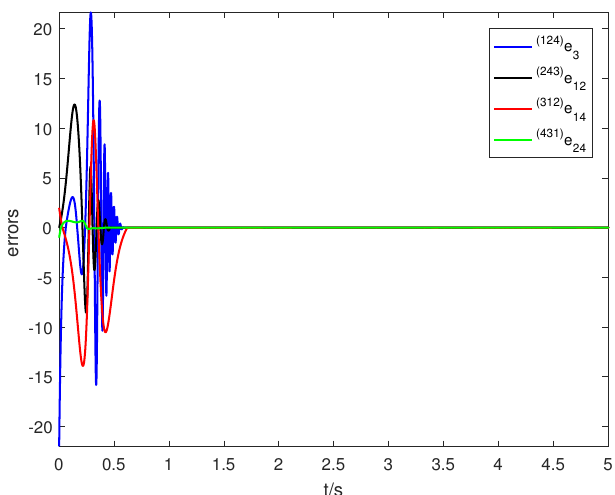
Figure 2. The synchronization errors ( 124 ) e 3 , ( 243 ) e 12 , ( 312 ) e 14 , ( 431 ) e 24 change with time t .